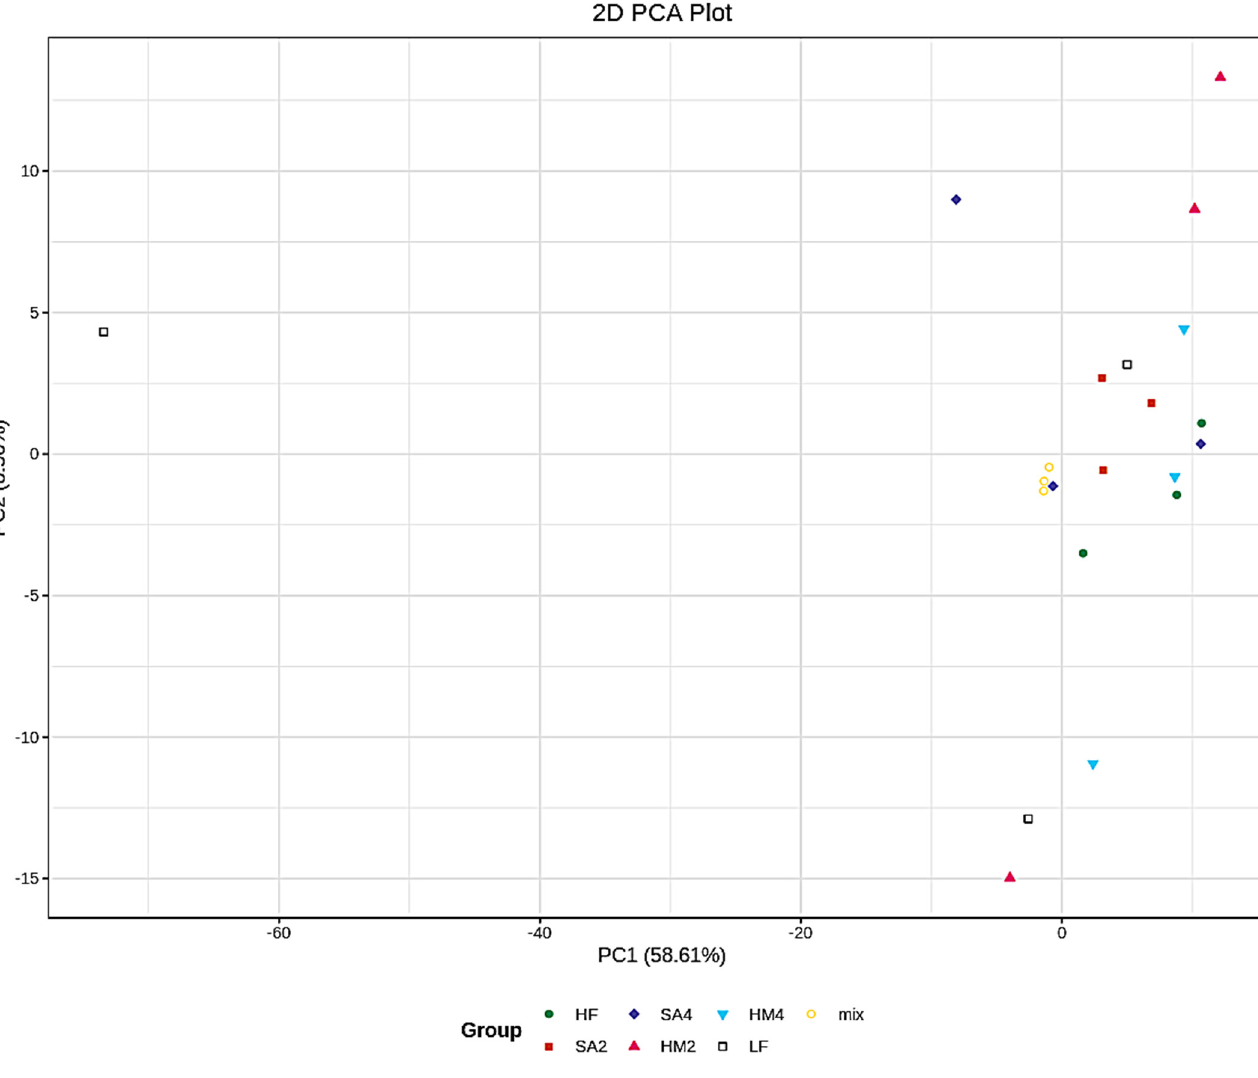
Figure 1. The abscissa represents the first principal component, the ordinate represents the second principal component, and the percentage represents the value of the contribution of the principal component to the sample difference. Each point in the figure represents a sample, and samples from the same group are represented using the same color.